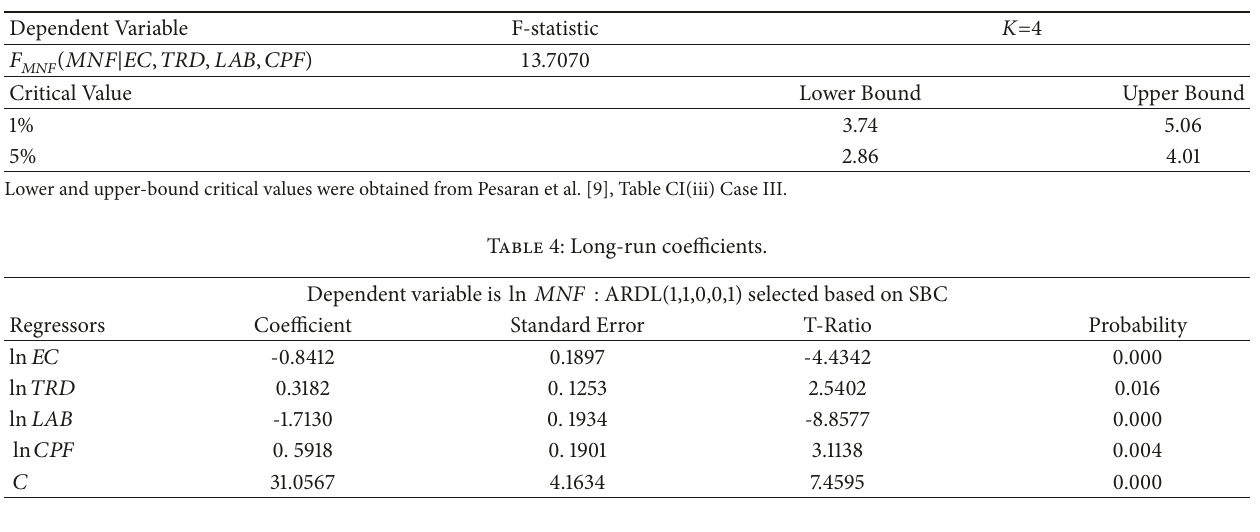
Table 3: ARDL bound test.